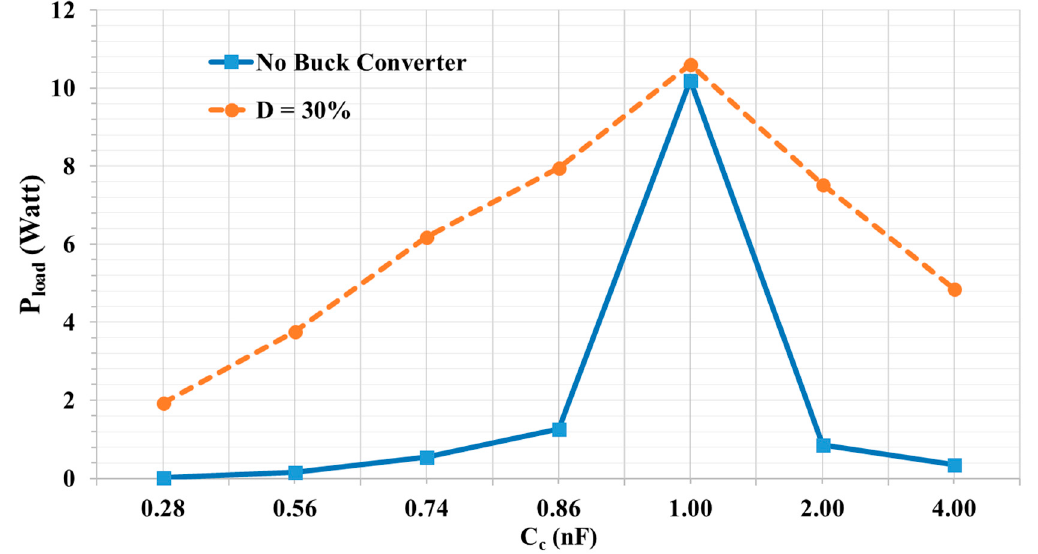
Figure 15. The tolerance of the output power with the change in the capacitive interface equivalent series value.